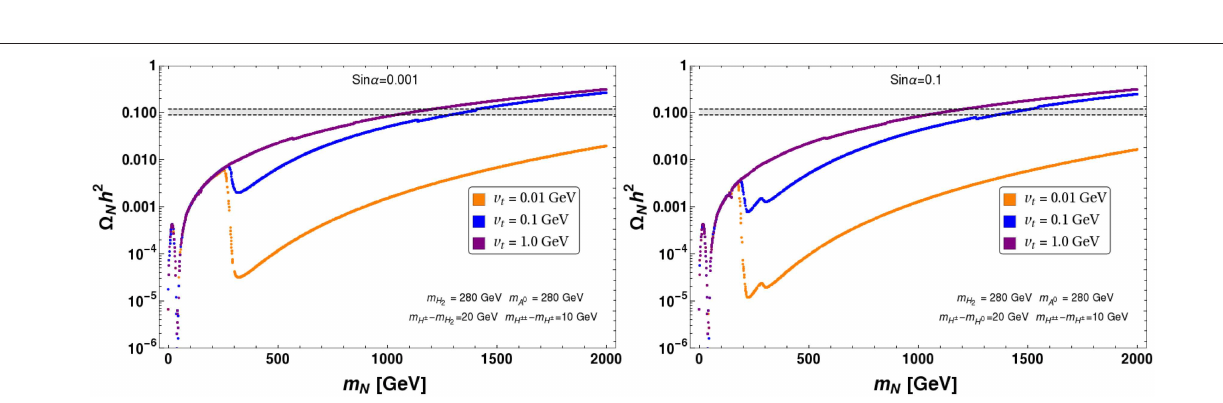
FIGURE 10 | Co-annihilation processes involving only charged partner of ILD DM, N ± in presence of scalar triplet.